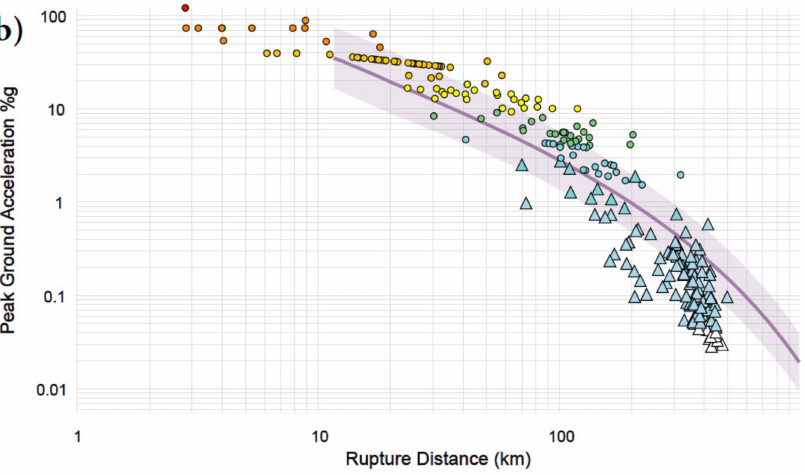
Figure 12. USGS Shake Map analysis: ( a ) The peak ground acceleration map and ( b ) GMPE peak ground acceleration predictions (thick purple line) and observations (seismic stations—blue triangles, Did You Feel It DYFI—coloured circles) in consideration of local site effects [59].